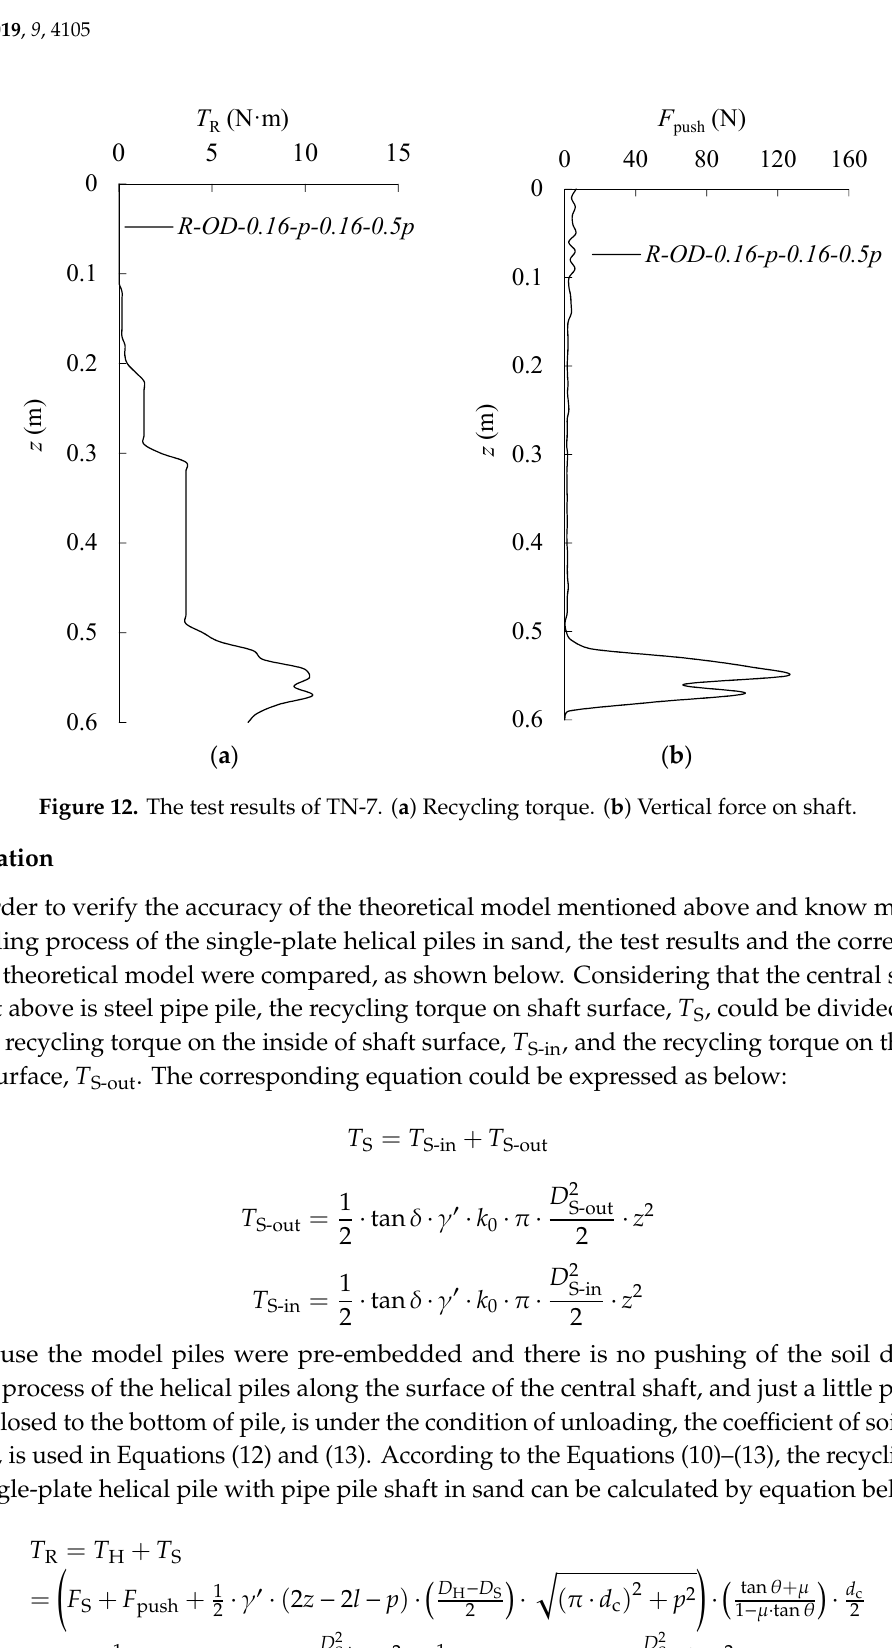
Figure 11. The test results of TN-6. ( a ) Recycling torque. ( b ) Vertical force on shaft.